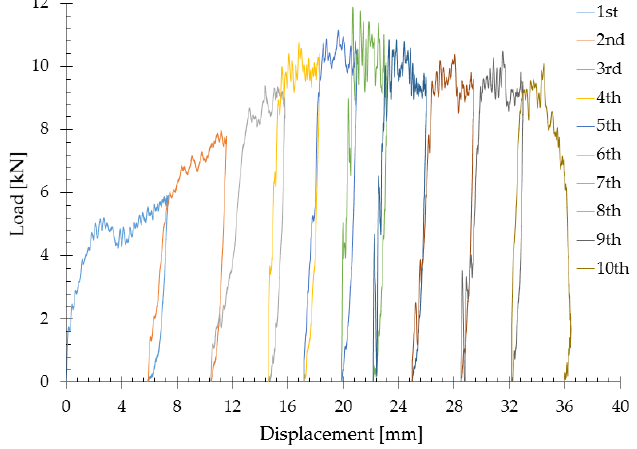
Figure 8. Loading and unloading curves for a Type IV specimen subjected to repeated impacts at impact energy equal to 35 J.